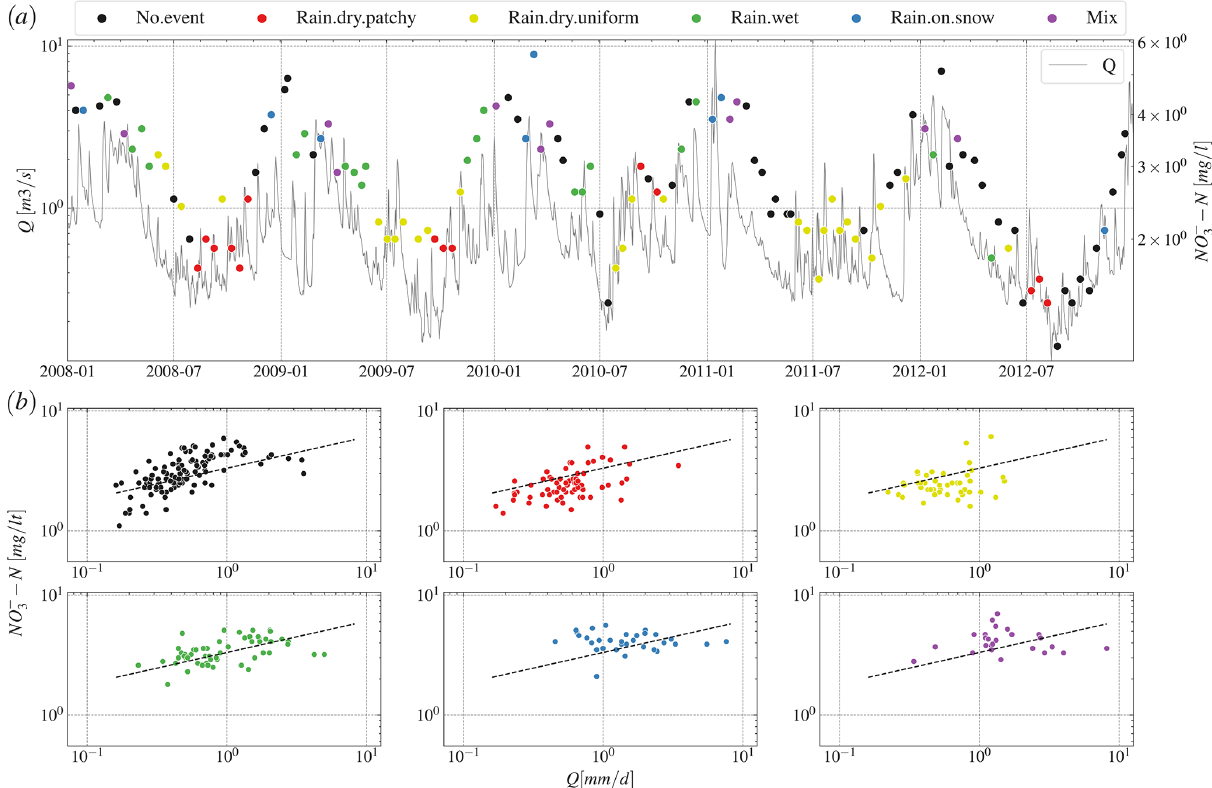
Figure 1. (a) Time series of daily discharge and biweekly grab sample nitrate concentrations during event and no-event conditions in the Naab River at the gauge of Unterköblitz, Bavaria over a period of 5 years. Event types are differentiated by colors (see Fig. 3 for details). (b) Double logarithmic plot of C – Q pairs for samples (from 2000 to 2012) taken during different event types and no-event conditions. Dashed black lines show the long-term C – Q relationships (same line in each subplot) obtained from linear regression in a double logarithmic plot of C – Q values for all available